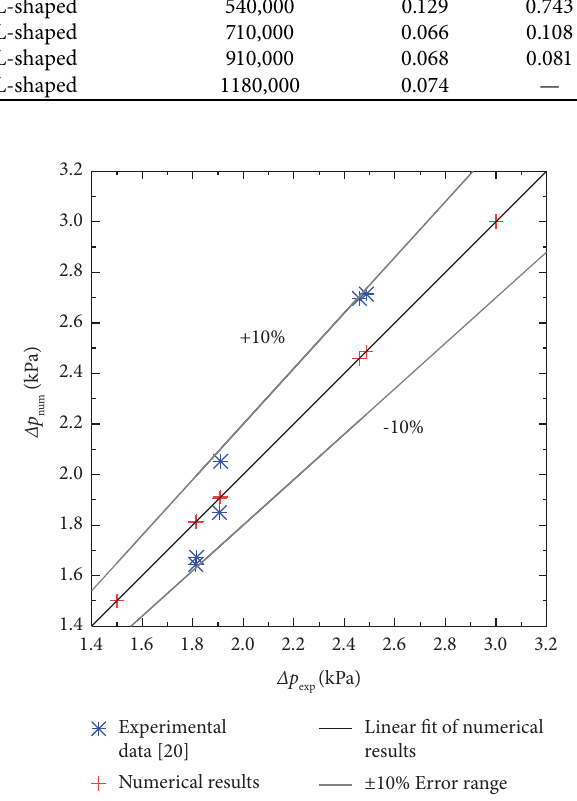
Figure 3: Comparison of numerical results and experimental data [20]. Table 2: Numerical conditions under diferent α and Re sponding to Azzi and Friedel [20].